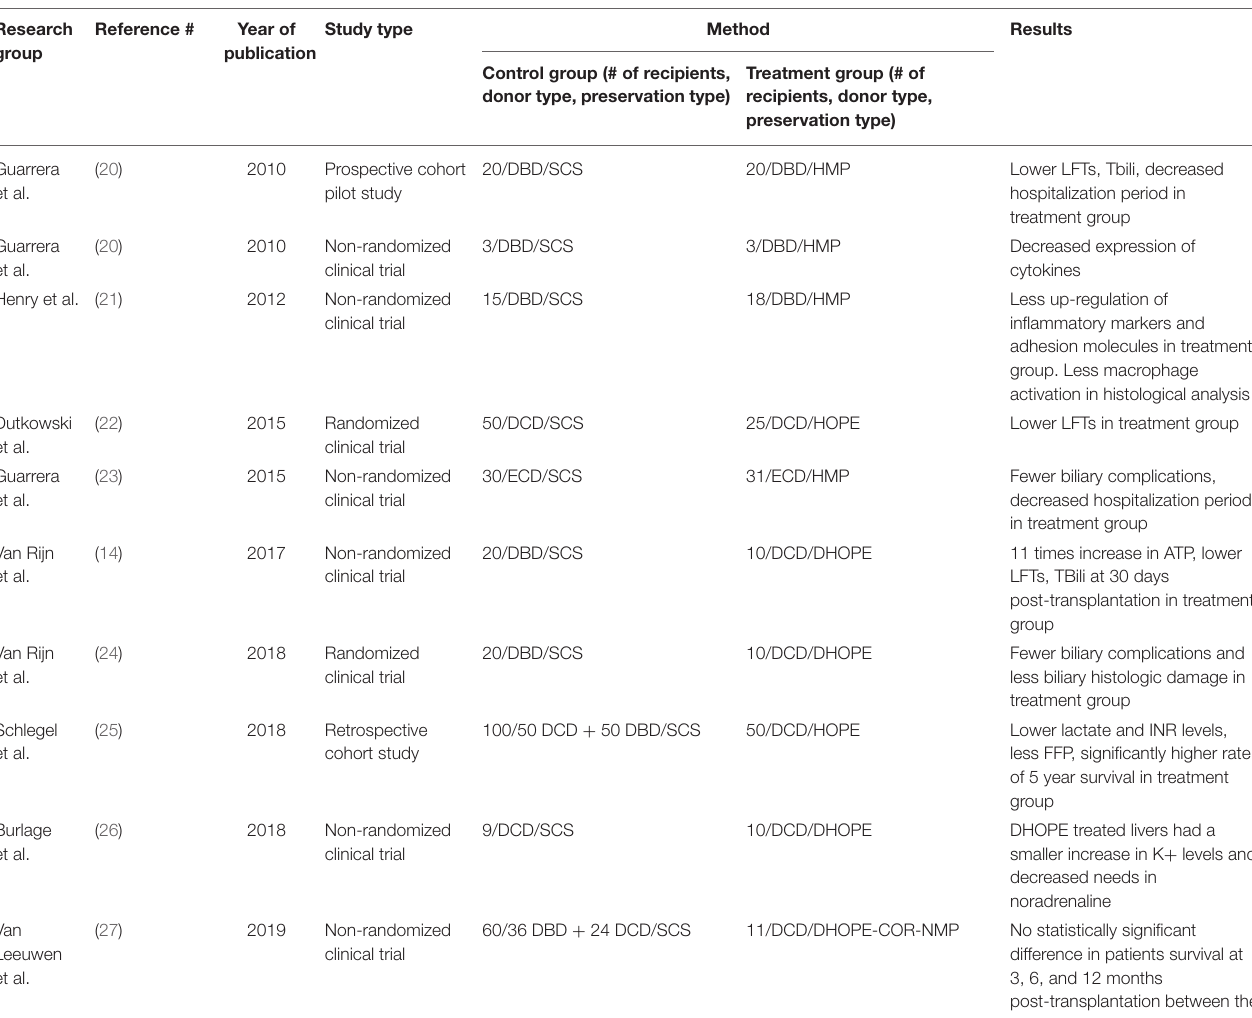
TABLE 1 | HMP clinical trials and